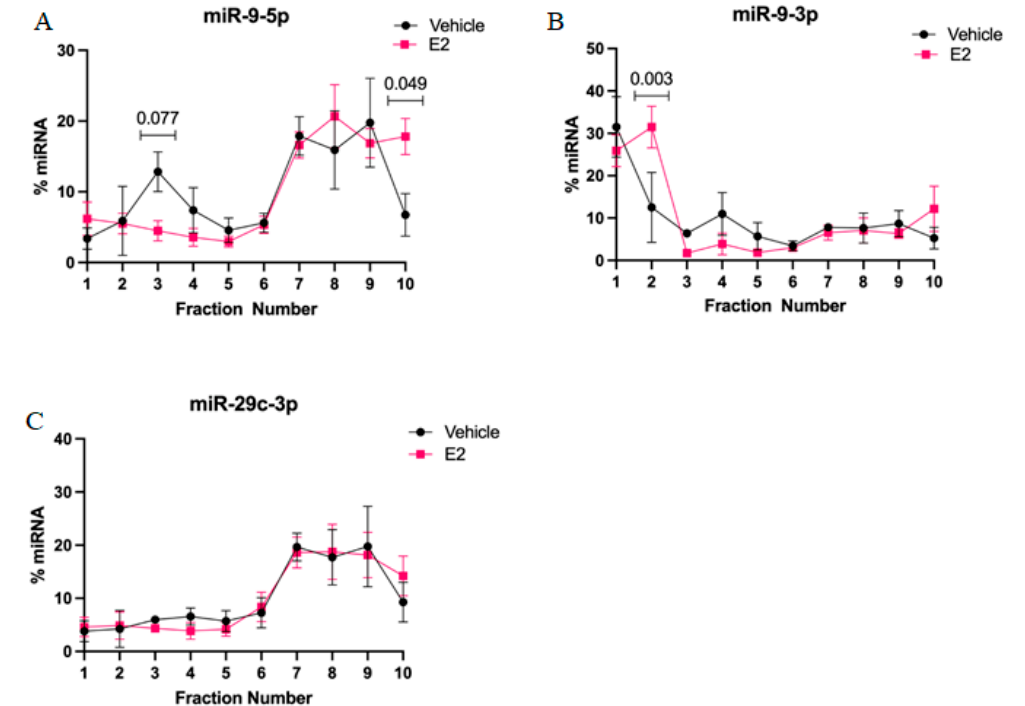
Figure 6. E 2 altered miR-9-5p and miR-9-3p polysome occupancy in hypothalamic-derived neuronal cells. Cells were treated with E 2 for 15 h and fractionated using sucrose gradient density sedimentation. Total RNA was isolated from fractions 1–10 and analyzed for expression levels of ( A ) miR-9-5p, ( B ) miR-9-3p, and ( C ) miR-29c-3p. Data were analyzed using unpaired two-sample T-test comparing treatments within each fraction. Data are represented as mean % total mRNA ± SEM ( N = 3 independent experiments). Significance was noted when p < 0.05.